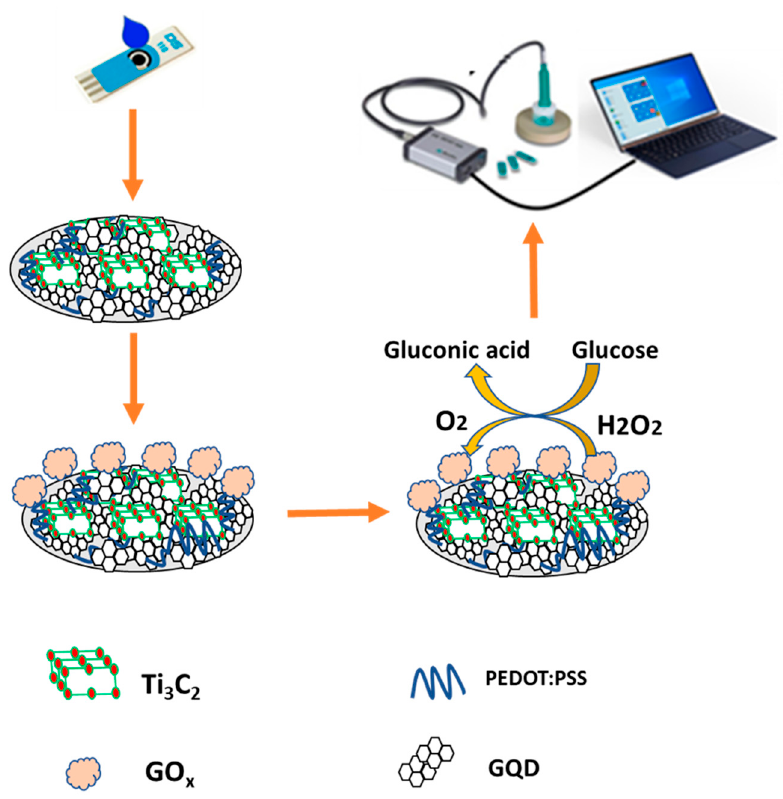
Figure 1. Schematic diagram of fabricated PEDOT:PSS/Ti 3 C 2 /GQD modified SPCE for glucose de- tection.